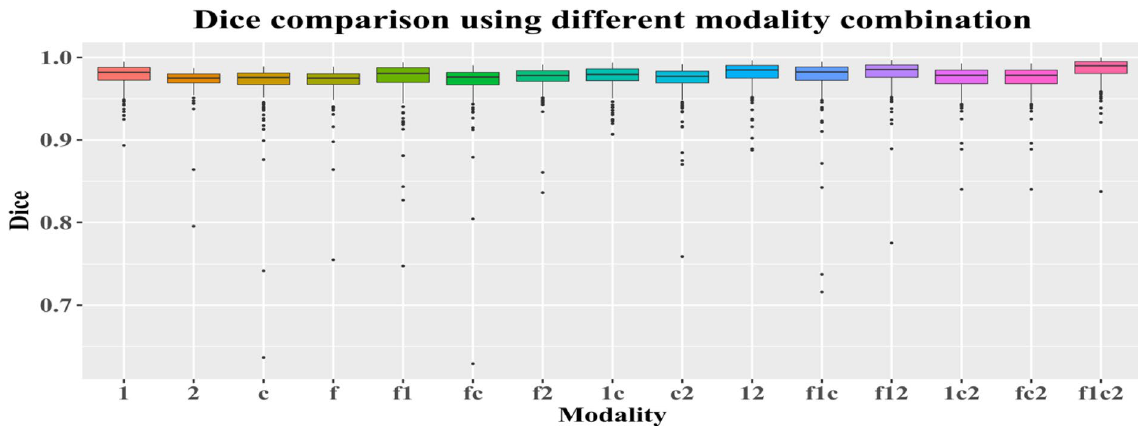
Figure 8. Quantitative dice comparison using different modality combination in the testing phase. In the x axis, 1, 2, c, and f representsT1, T2, T1ce, and T2-FLAIR, respectively. For an example, f1ce means that the combination has all four image